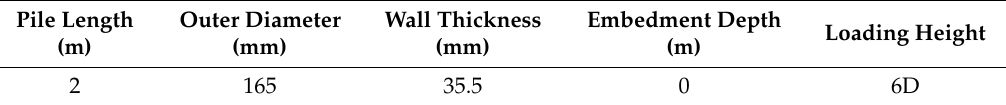
Table 1. Parameters of testing model